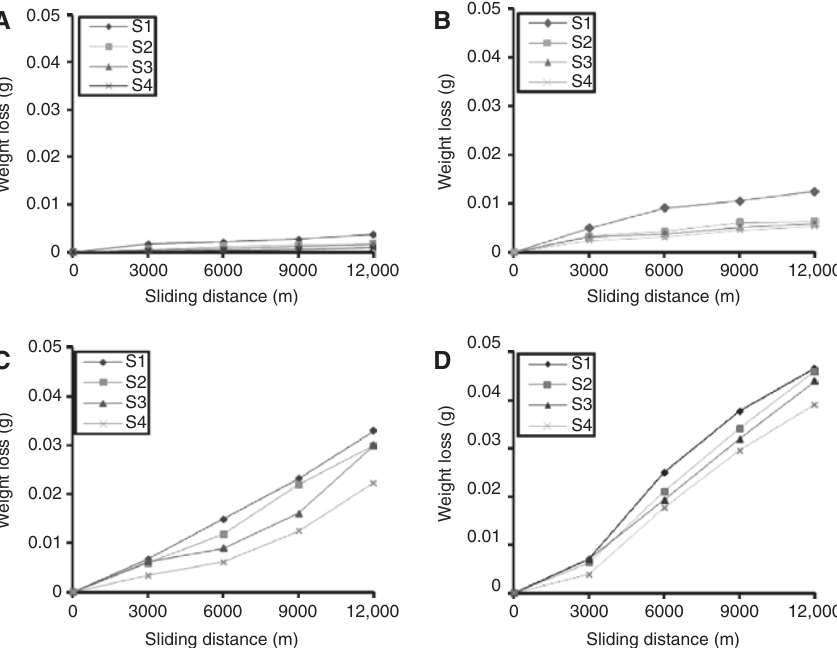
Figure 4: The effect of the sliding distance and the applied load on the weight loss of (A) 10, (B) 20, (C) 30 and (D) 40 N.